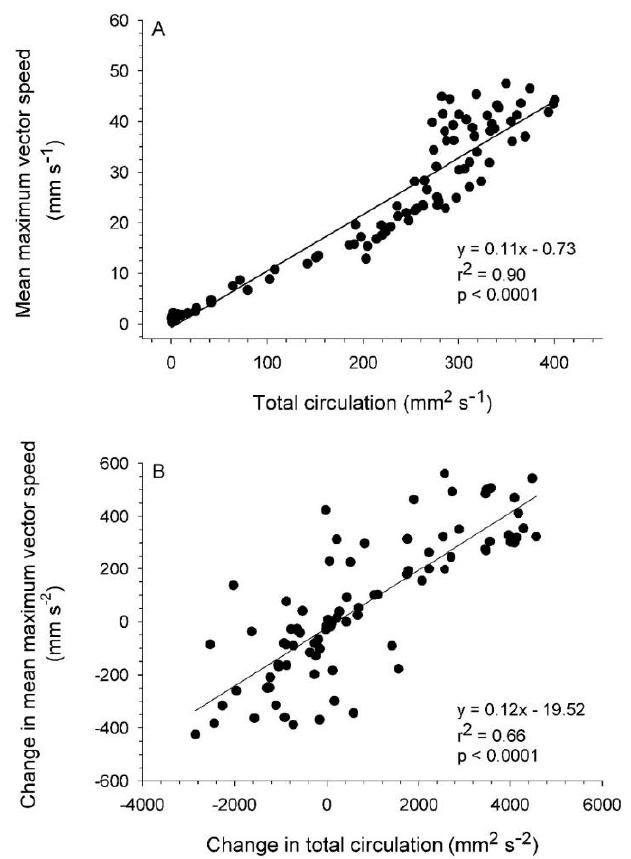
Figure 7. Linear correspondence between starting vortex circulation magnitude and VIA jet magnitudes for the hydromedusa Eutonina indicans . ( A ) Total, or combined, circulation of starting vortices compared to the mean of maximum VIA vector speeds adjoining both vortices and ( B ) change in total circulation and mean maximum vector speeds. All data represent 2D measurements derived from particle image velocimetry (PIV) images for the pulsation cycles depicted in Figures 2 and 3.